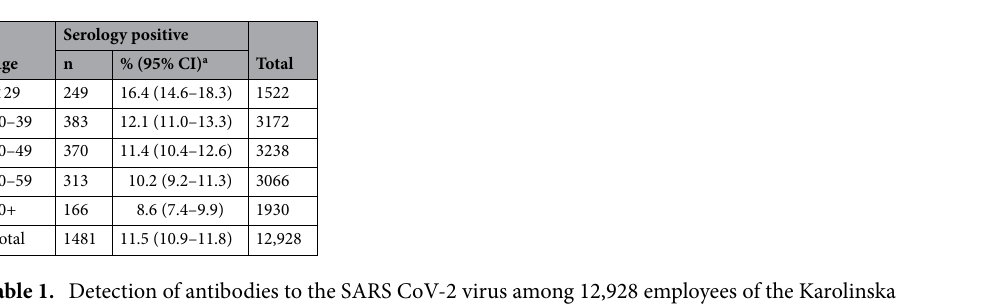
Table 1. Detection of antibodies to the SARS CoV-2 virus among 12,928 employees of the Karolinska University Hospital, by age. a Cochran–Armitage trend test for decreasing prevalence with increasing age, p value <